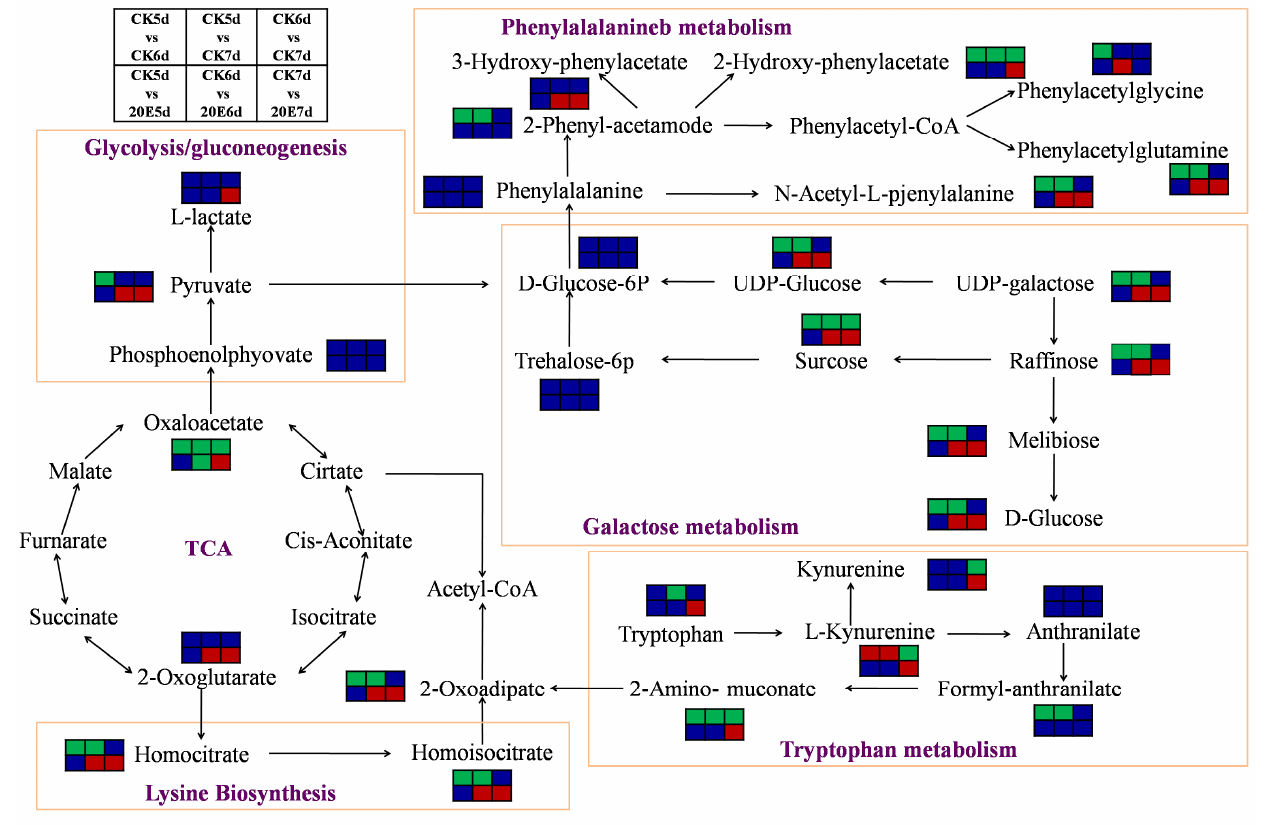
Figure 6. Changes in key metabolites mapped to metabolic pathways in worker bee larvae samples pairwise comparisons. Note: The small red rectangle indicates that metabolite content is significantly upregulated; the small green rectangle indicates that metabolite content is significantly downregulated; the small blue rectangle indicates no significant difference in that metabolite content.